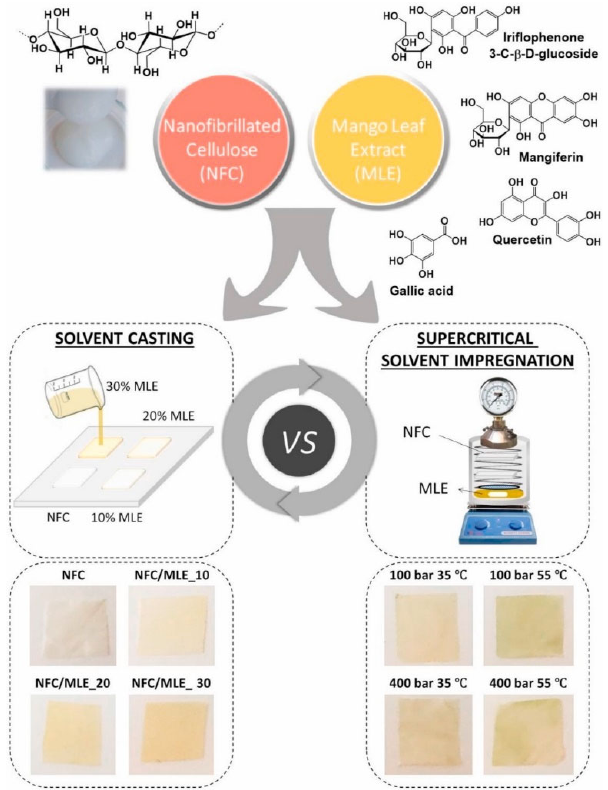
Figure 2. A schematic diagram illustrating the preparation of NFC/MLE ‐ based films via either solvent casting or SSI. Reproduced from [35] with permission from Elsevier B.V.